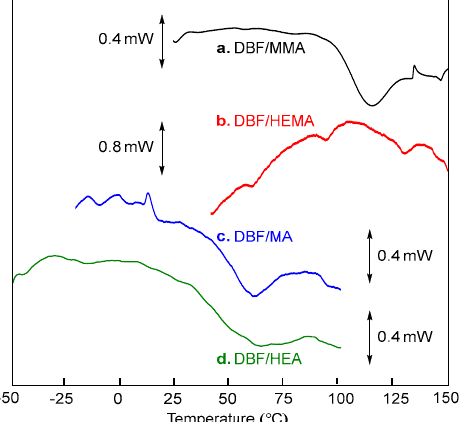
Figure 5. DSC profiles of poly(DBF- co -MMA) ([DBF]/[MMA] in polymer = 82/18) (6.7 mg) (a), poly(DBF- co -HEMA) ([DBF]/[HEMA] in polymer = 73/27) (4.6 mg) (b), poly(DBF- co -MA) ([DBF]/[MA] in polymer = 87/13) (4.3 mg) (c), and poly(DBF- co -HEA) ([DBF]/[HEA] in polymer = 89/11) (4.3 mg) (d) (second heating scan at a rate of 10 °C/min). Intensity of all profiles has been normalized to a sample amount of 10.0 mg.